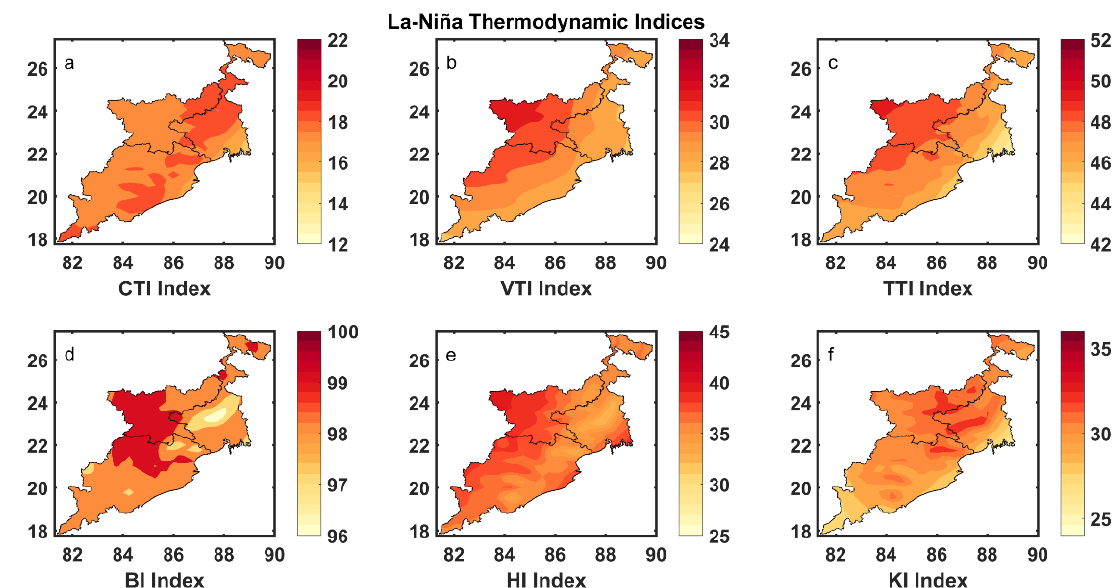
Figure 6. CTI ( a ), VTI ( b ), TTI ( c ), BI ( d ), HI ( e ), KI ( f ) variations during El-Niño years from 1998 to 2014.